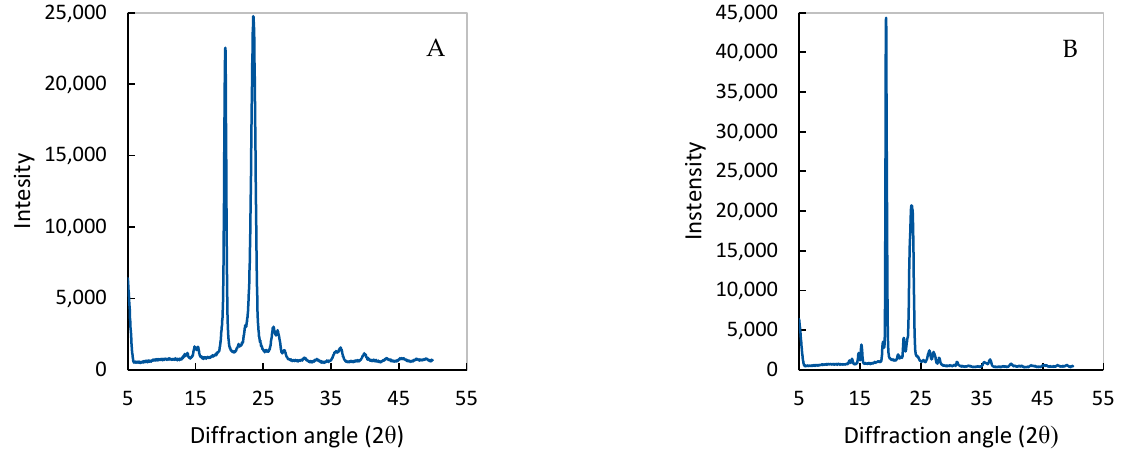
Figure 2. Powder X-ray diffraction patterns of ( A ) PEG4000 and ( B ) Figure 2. Powder X ‐ ray diffraction patterns of ( A ) PEG4000 and ( B ) PEG6000. PXRD Patterns of Solid Dispersions